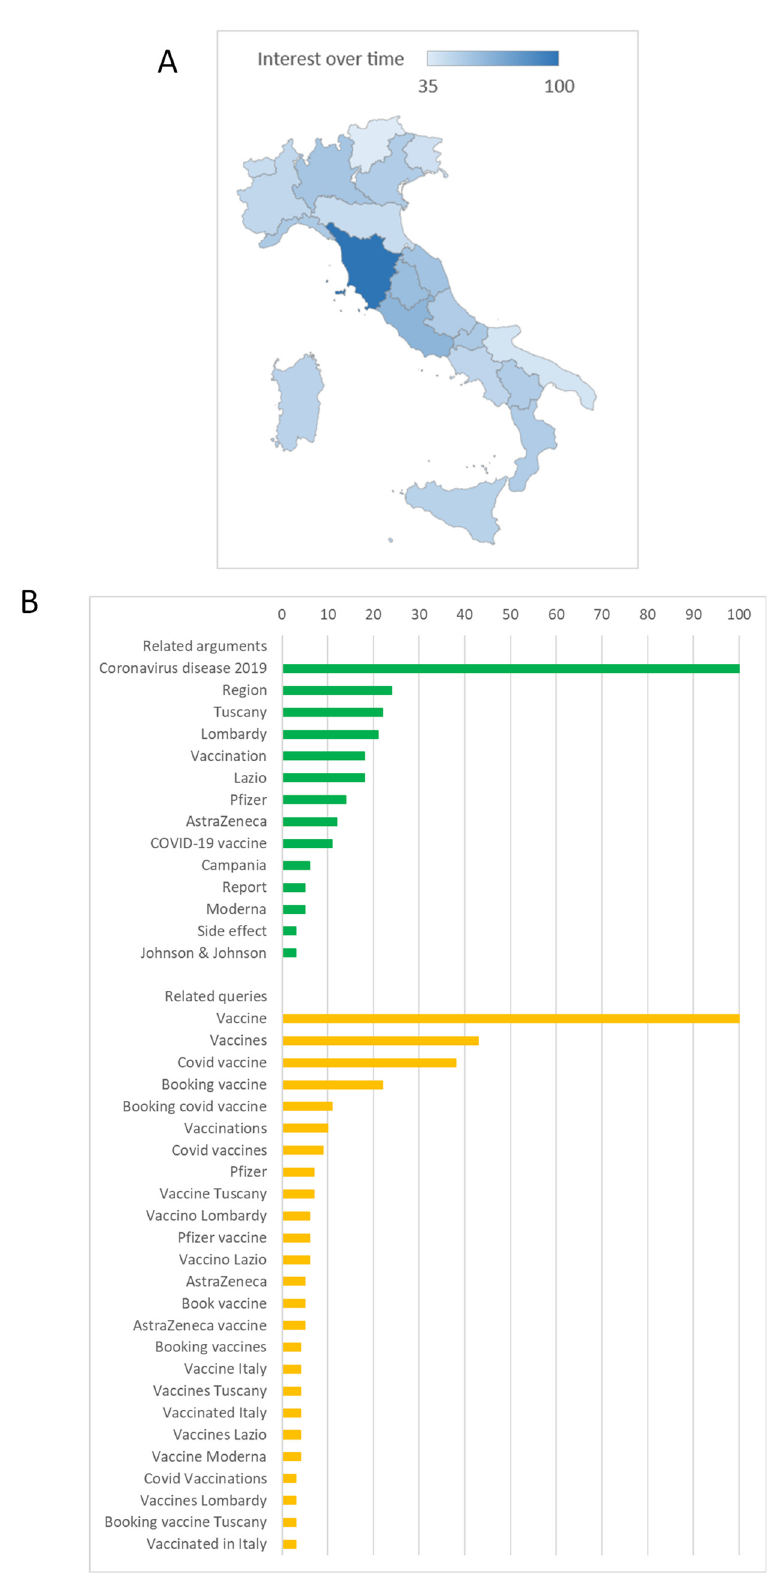
Figure 2. Search interest for the keyword Vaccine (Argument). ( A ) Comparison of Google Trends data across Italian regions; ( B ) the most common arguments and queries related to Vaccine (Argument).